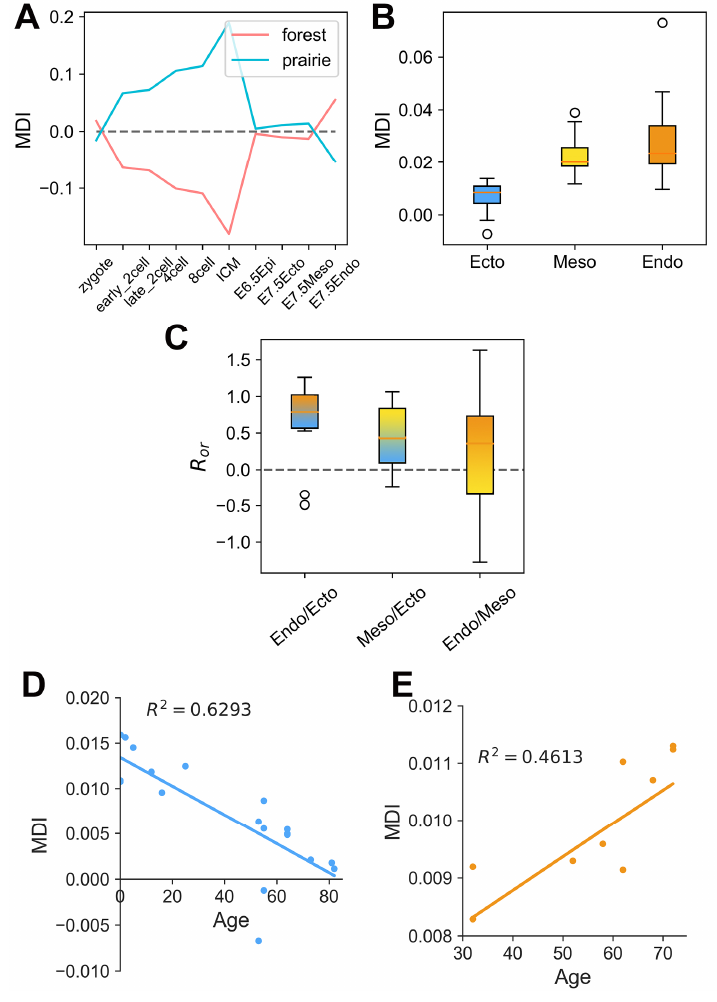
Figure 3. The association between domain segregation and DNA methylation. ( A ) The average forest– prairie open-sea methylation level difference (MDI) at different stages during mouse embryonic development. ( B ) The box plots of the average MDI for human differentiated cells originating from endoderm, mesoderm and ectoderm, respectively, for forest domains. ( C ) The box plots of the overall relative segregation ratio R or (see “Methods”) of one tissue over another for forests in human embryos. The three categories are tissues derived from endoderm and mesoderm over those derived from ectoderm, and endoderm over mesoderm. The parameter R or was used to evaluate the differences in domain segregation behaviors between two tissues. For example, as for tissues 1 and 2, N 12 and N 21 represent the number of domains showing a higher DR s in tissues 1 and 2, respectively. The overall relative segregation ratio for tissues 1 and 2 is then defined as ln ( N 12 ) − ln ( N 21 ) , a positive value of which thus indicates that the chromatin structure of tissue 1 is more segregated, compared to tissue 2. ( D , E ) The scatter-plots of age and methylation difference for brain cells ( D ) and mature neutrophil cells ( E ) for forest domains in human